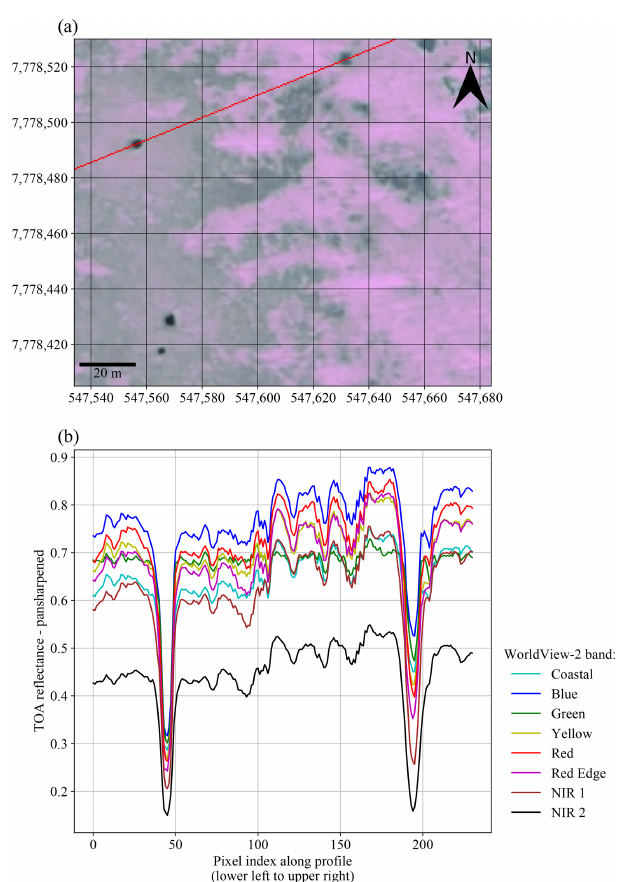
Figure 2. Examples of features in WorldView-2 imagery acquired on 22 May 2016 and associated spectral profile. (a) WorldView-2 true-colour composite with red line indicating the pixels used for plotting the profile (CRS: WGS 84 / UTM zone 42N). (b) Spectral profile indicating variations between contrast for the two main min- ima. The left main minimum was considered a hole that should be detected, while the right minimum was not considered a hole, and its detection should be